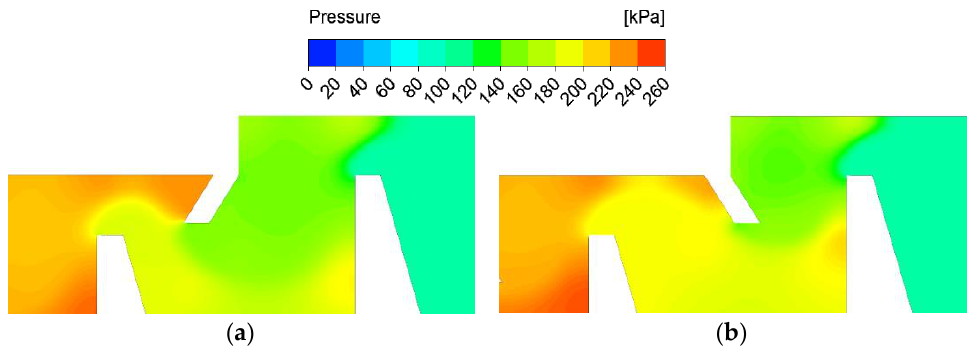
Figure 17. Static pressure contour plots for various β (PR = 2.5, S/H = 1.0, t/K = 2.0). ( a ) β = 60°. ( b ) β = 120°.